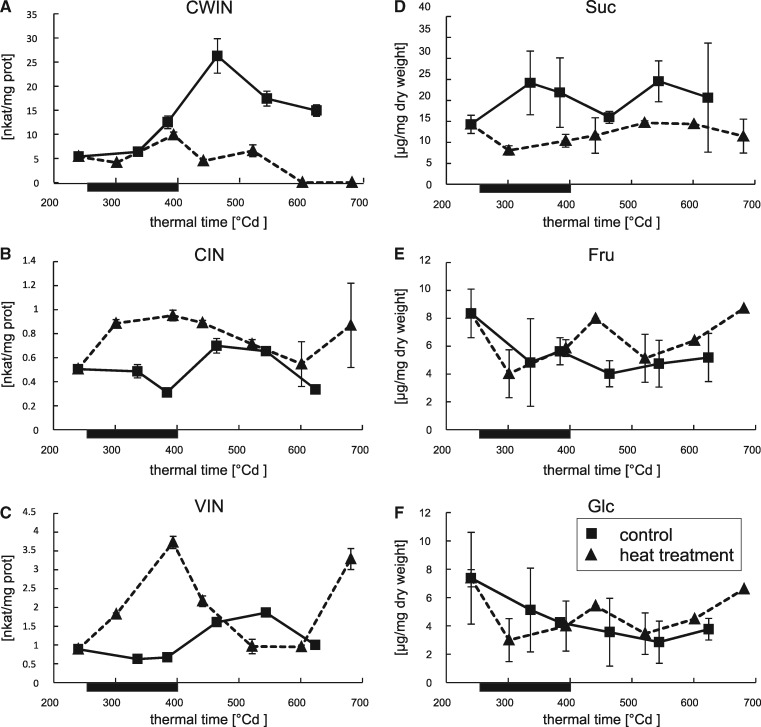
Effect of the heat wave on the sucrolytic enzymes and the content of their substrate and reaction products in the in flag leaves. Depicted is the phase of starch accumulation (starting with DAF 15, 240�Cd). The duration of the heat wave is indicated by a black bar on the abscissae of each graph. Squared symbols represent data points from plants grown under control conditions, while triangles represent plants that suffered from a heat wave between days 16 and 21 after anthesis. Time is shown as thermal time (�Cd) to facilitate comparison between the two curves shown. Enzyme activities are shown in nkat per mg protein for (A) CWIN, (B) CIN, (C) VIN and (D) Suc, (E) Fru, (F) Glc. For analysis, material from three biological replicates was pooled. Error bars represent � the standard deviation of three measurements of the combined sample.